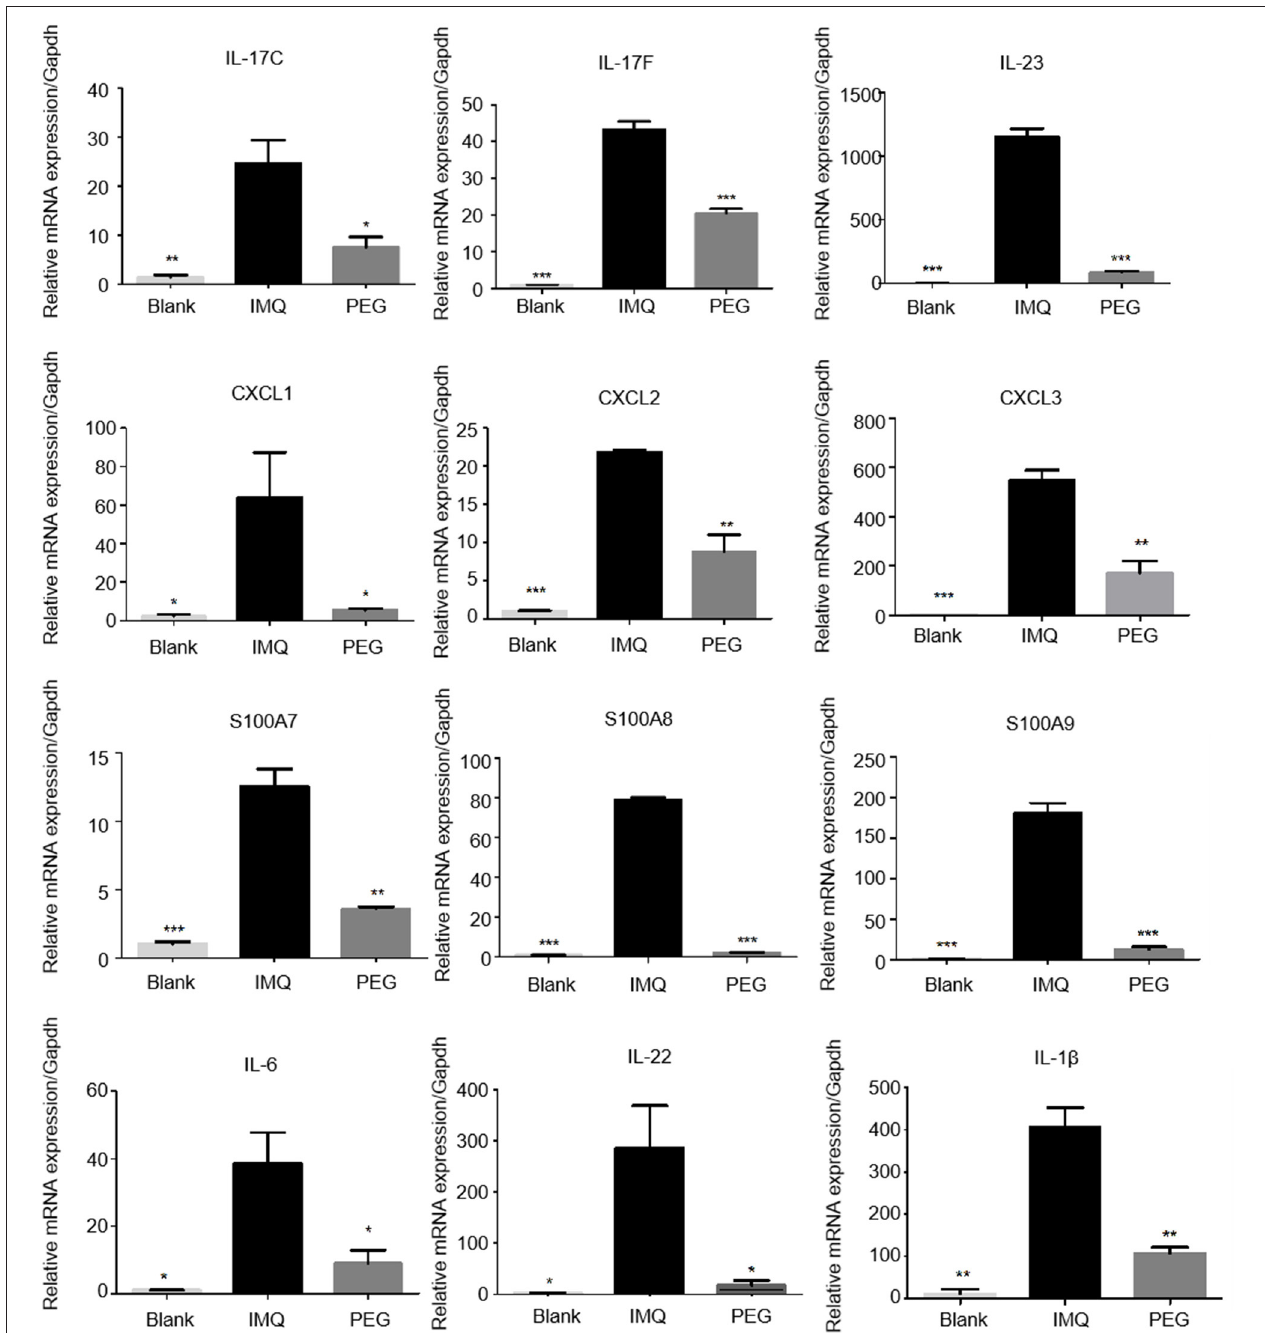
FIGURE 5 | The mRNA expression levels of IL-23, IL-17C, IL-17F, IL-22, S100A7, S100A8, S100A9, CXCL1, CXCL2, CXCL3, IL-1 β , and IL-6 in the skin lesions of each group (*compared to the IMQ group, * P < 0.05,** P < 0.01,*** P < 0.001). We have repeated the experiment more than three times.